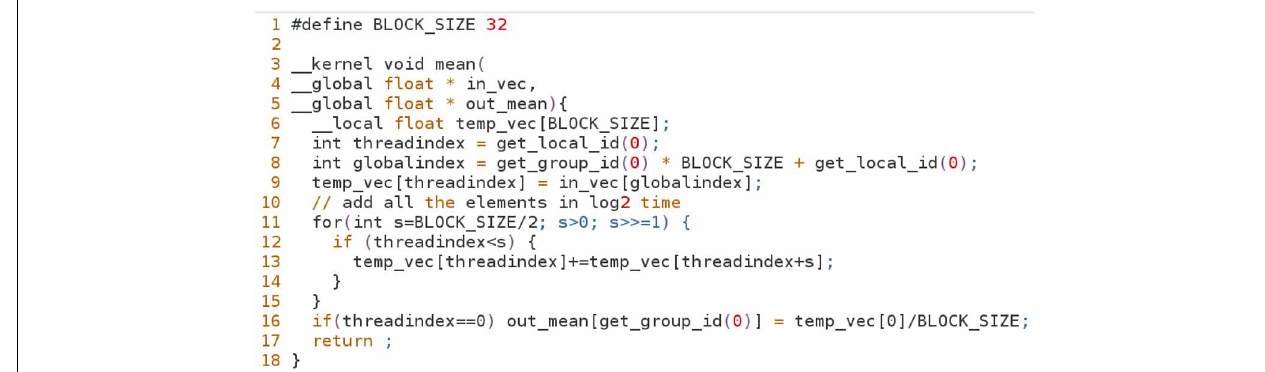
FIGURE A4 | OpenCL kernel for computing means across different